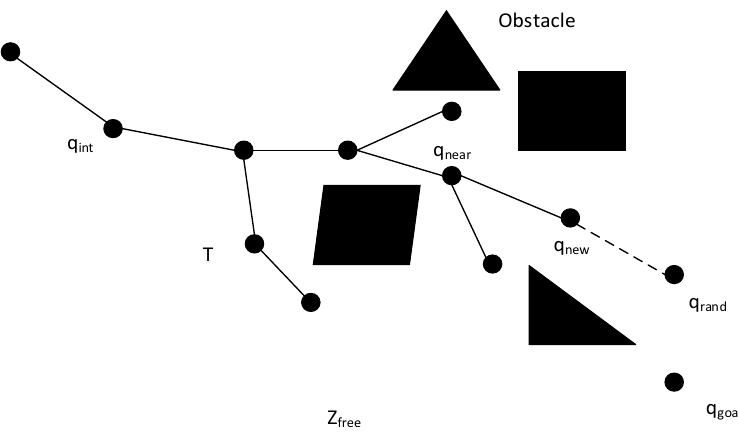
Figure 1. Basic RRT algorithm random expansion tree growth diagram.